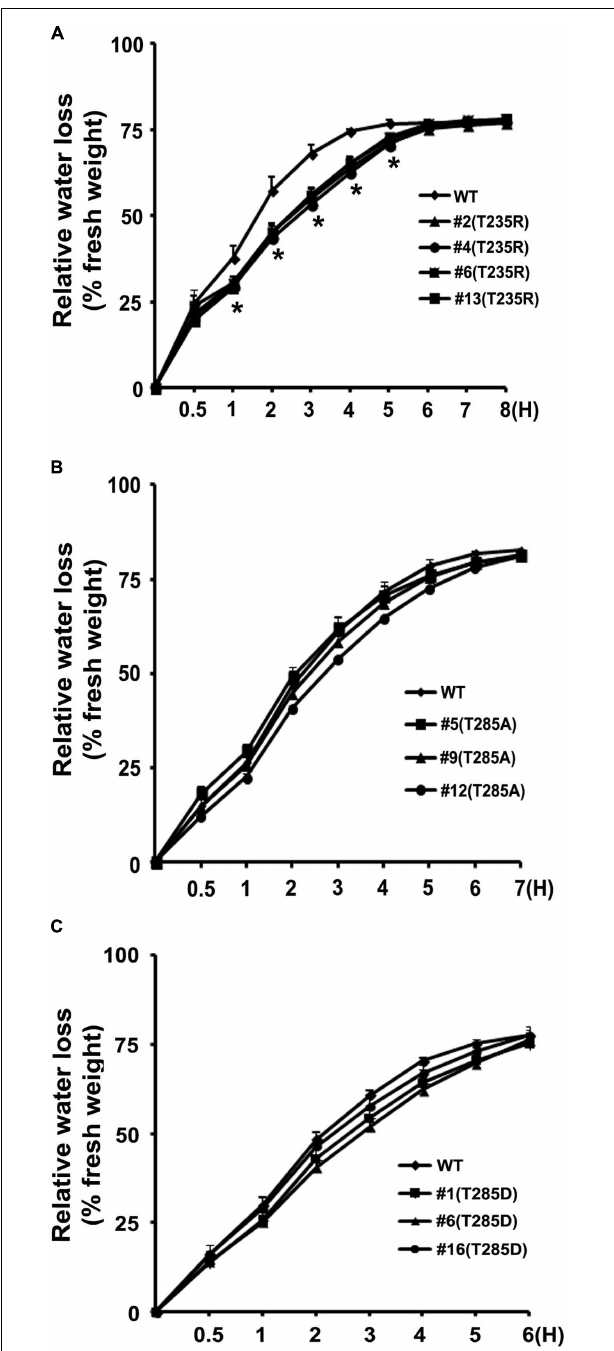
FIGURE 3 | Water loss assay of transgenic rice plants overexpressing OsKAT2 mutant proteins. (A) Transgenic rice plants overexpressing OsKAT2(T235R), (B) transgenic rice plants overexpressing OsKAT2(T285A), (C) transgenic rice plants overexpressing OsKAT2(T285D). Relative water loss rates in detached leaves from wild-type and T2 transgenic rice plants expressing dominant-negative OsKAT2 mutant proteins under drought-stress conditions. Water loss is indicated as the percentage of weight loss versus the initial fresh weight. Results are means ± standard error (SEM). Asterisks indicate a significant difference (one-way ANOVA with Turkey’s test, ∗ p -value <